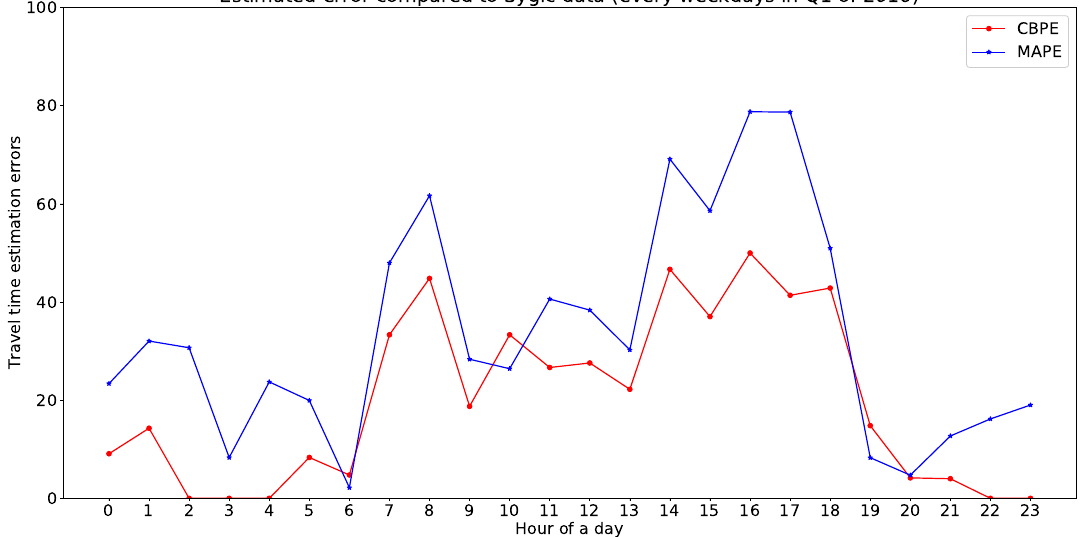
Figure 17. Different errors for the proposed model estimated travel time compared to Sygic data. Table 4. CBE, RMSE, and MAPE errors of estimated travel time compared to Sygic data for different hours of a day.